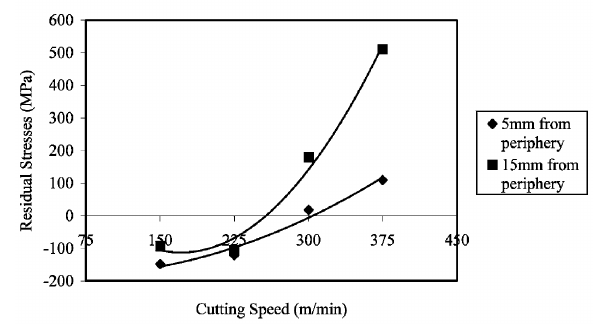
Figure 13: The relationship between cutting speed and residual stress